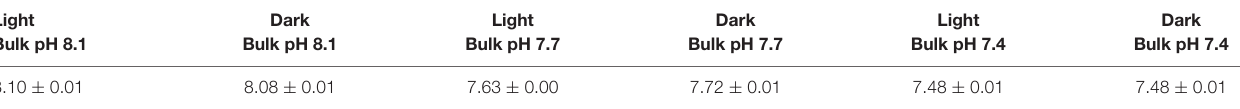
TABLE 2 | Bulk pH values (pH T ) of treatment conditions during oxygen profiling in the 3 L aquaria. Light Bulk pH